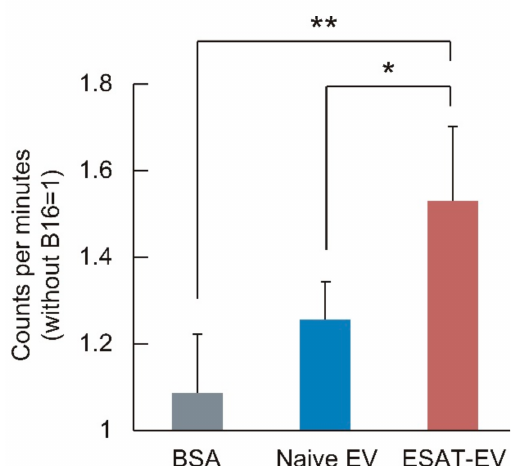
Figure 7. Thymidine incorporation by the leukocytes from EV-treated mice after co-cultured with B16 cells. Leukocytes in the popliteal lymph nodes were collected from mice treated with ESAT-EV, Naive EV, or BSA, and co-cultured with Mitomycin C pretreated B16 cells for 3 days. 3 H-thymidine was then added, and after overnight incubation, incorporation of the nucleoside into the lymphocyte was measured ( n = 4, mean ± SD, * p < 0.05 and ** p <